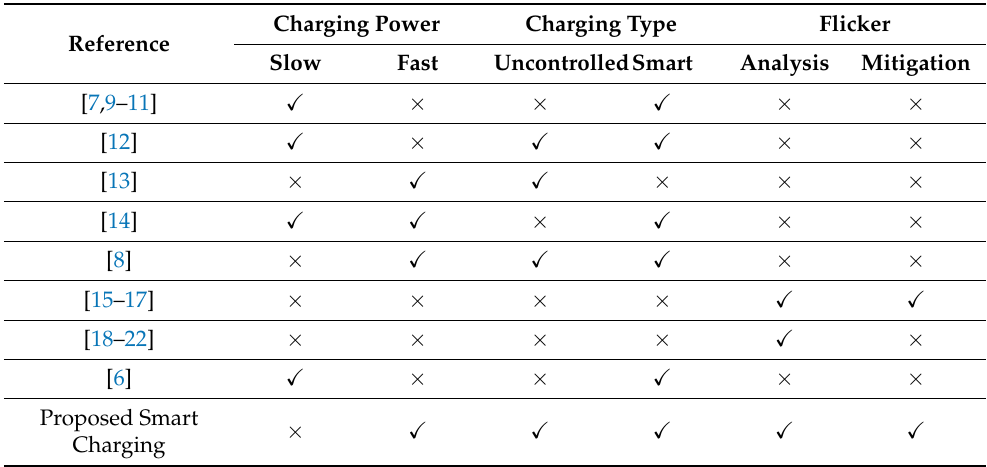
Table 1. Comparison of the previous work and the proposed method according to charging type and effect on light flicker.